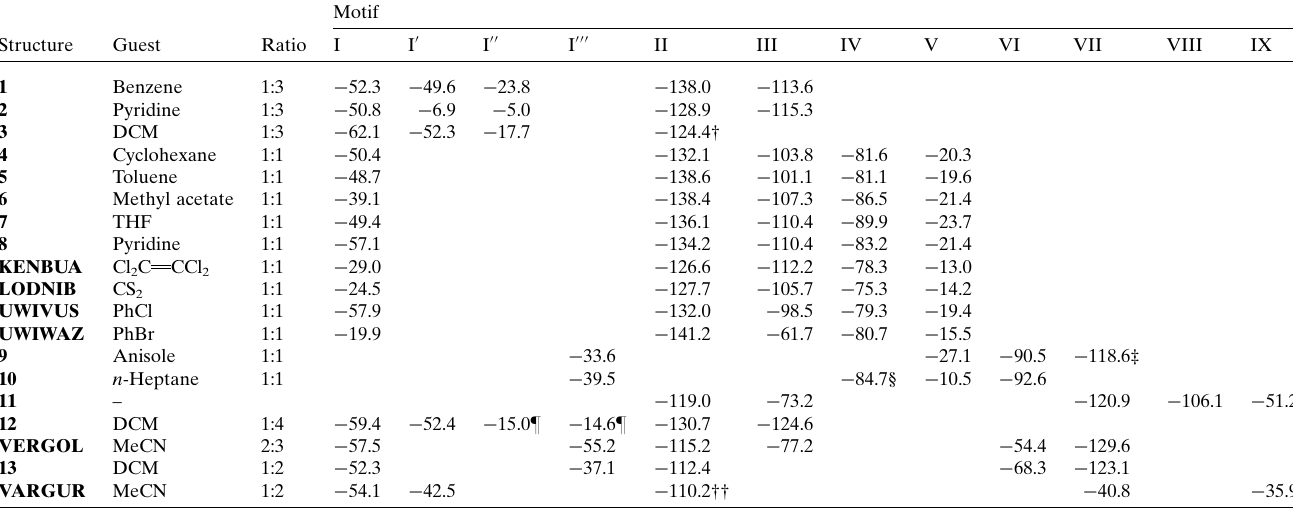
Table 1 Total interaction energies (kJ mol (cid:5) 1 ) for selected host–guest (I–I 000 ) and host–host (II–X) structural motifs in the analysed crystals calculated in CrystalExplorer using the Hartree–Fock method with the 3-21G basis set.